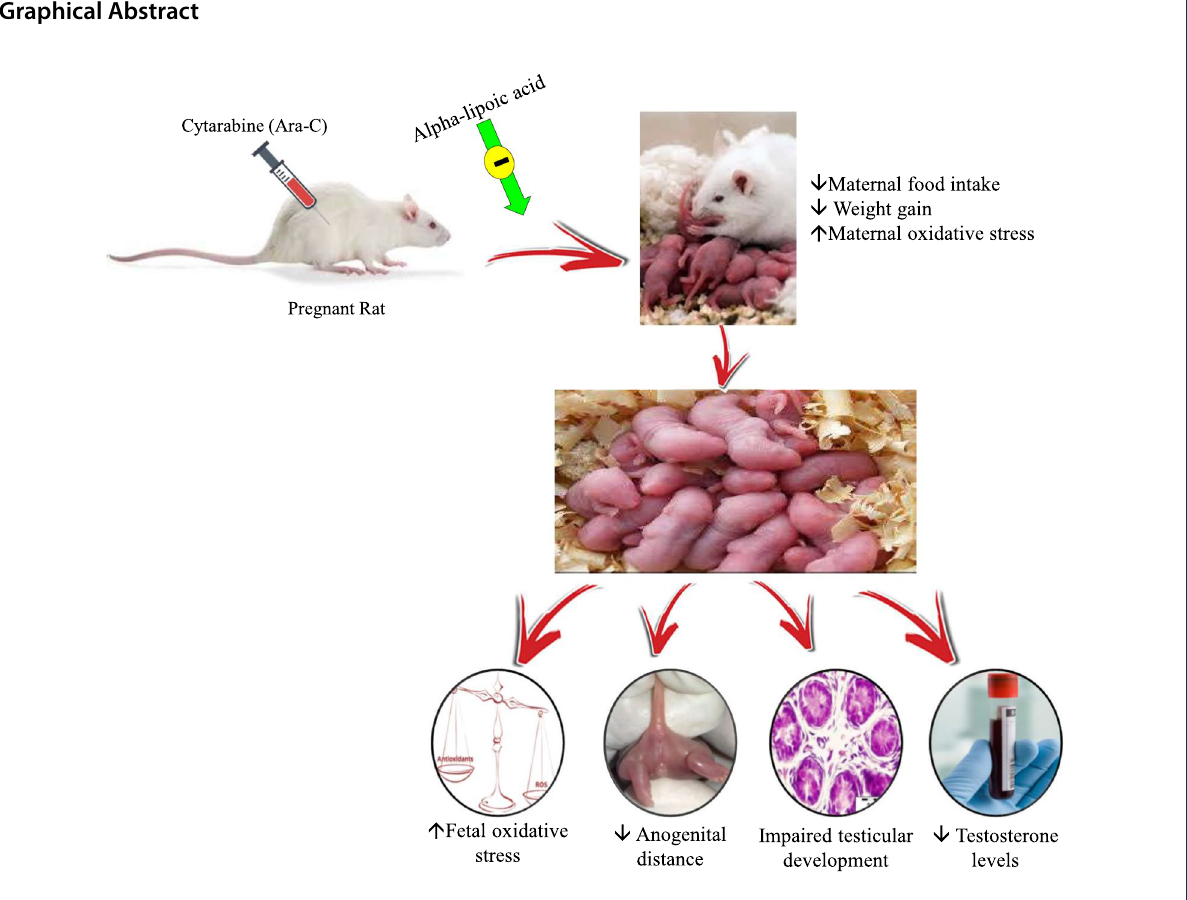
Keywords: Ara-C, Alpha-lipoic acid, Prenatal, Oxidative stress, Fetal testicular